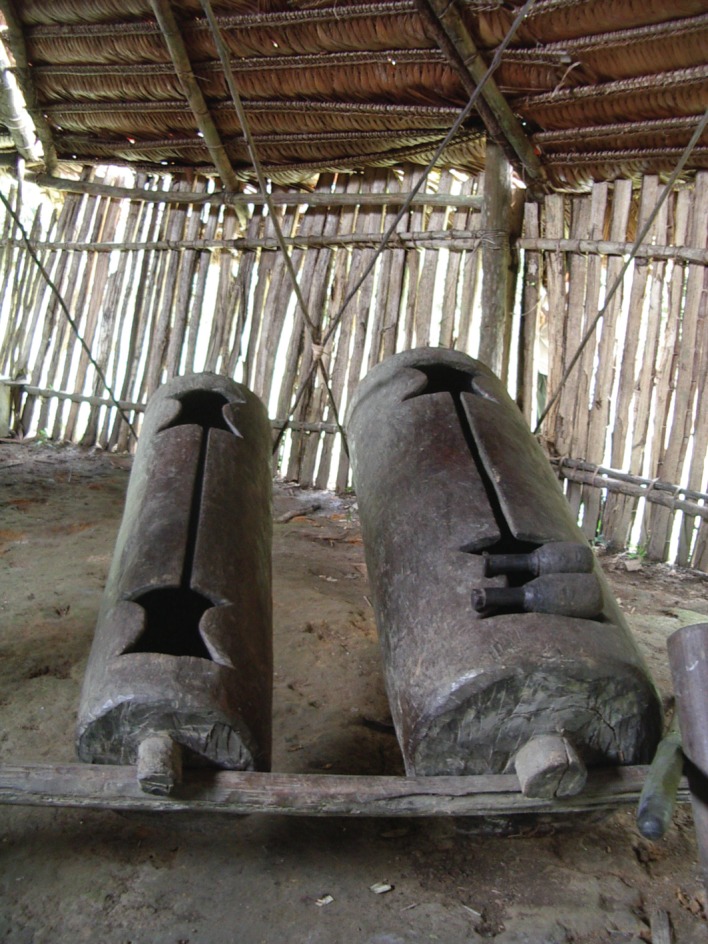
Manguaré drum pair in Brillo Nuevo, Peru (Photo Julien Meyer/Laure Dentel).